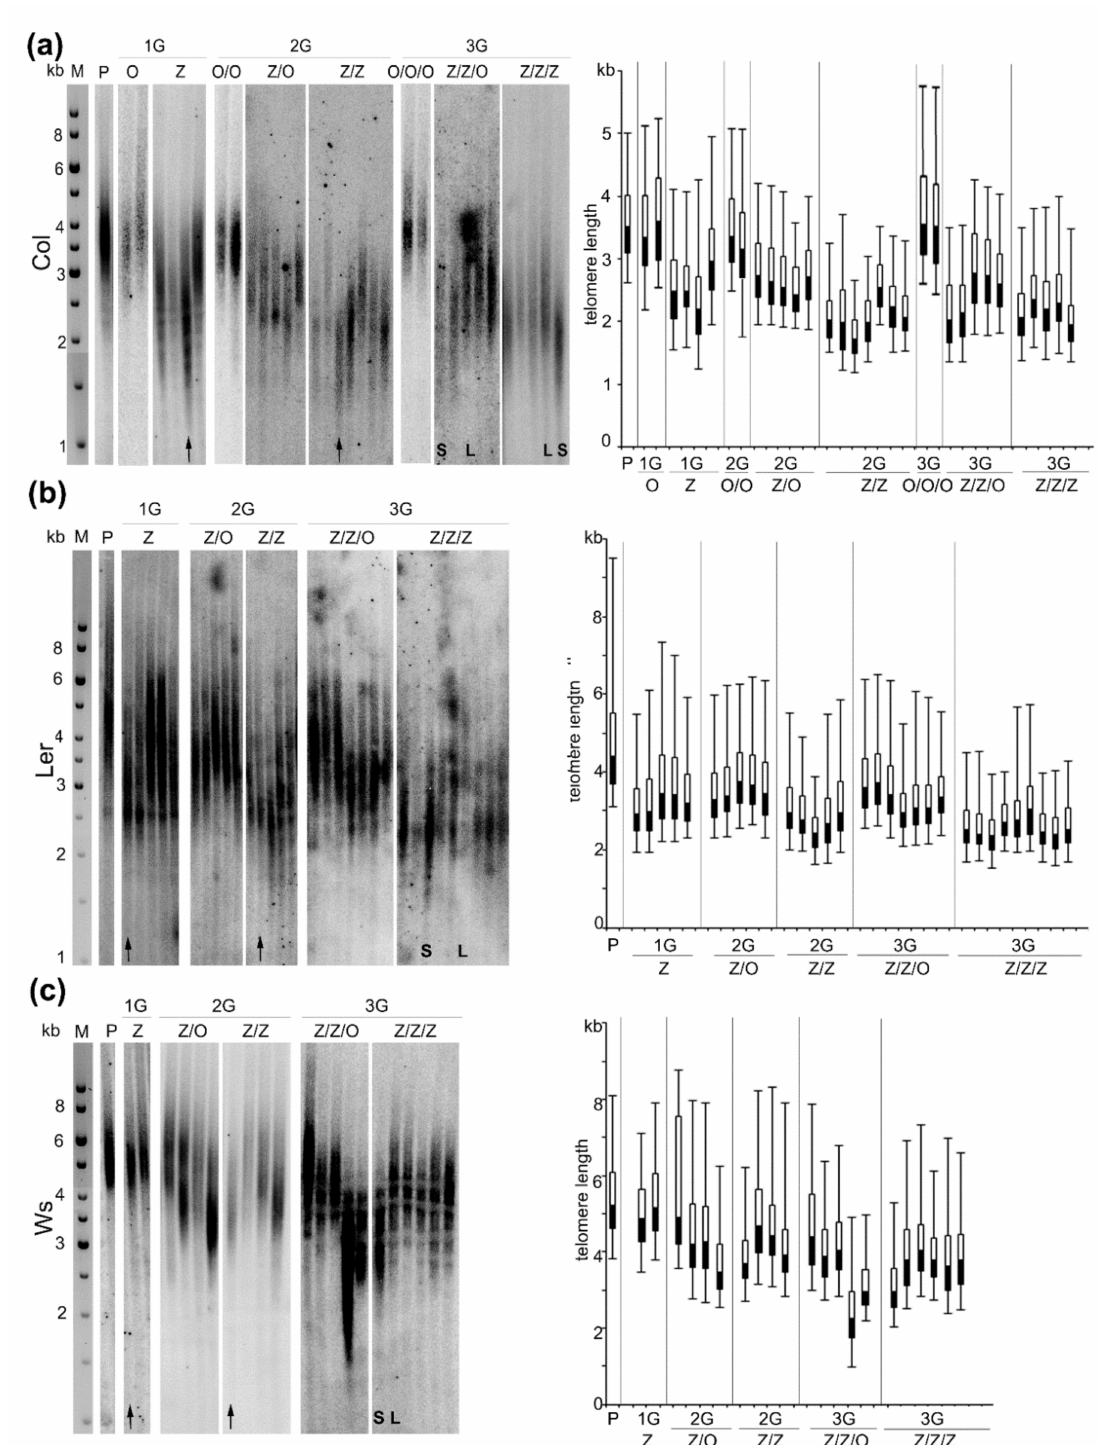
Figure 2. Lengths of telomeres in A. thaliana plants grown from seeds exposed to the zebularine during germination. ( a ) Seeds of Columbia-0 (Col); ( b ) Landsberg erecta (Ler); ( c ) Wassilewskija (Ws) ecotypes were exposed to the 250 µ M zebularine during germination for three generations; in parallel, progenies of zebularine plants were germinated on a control medium (for experimental design and nomenclature of samples, see Figure 1). Leaves for analysis were collected from 8-week-old plants. DNA was extracted from 2 g of leaves, 5 µ g of DNA was digested by MseI restriction endonuclease and analyzed by Southern hybridization using radioactively labeled telomeric probe. Each sample (line) corresponded